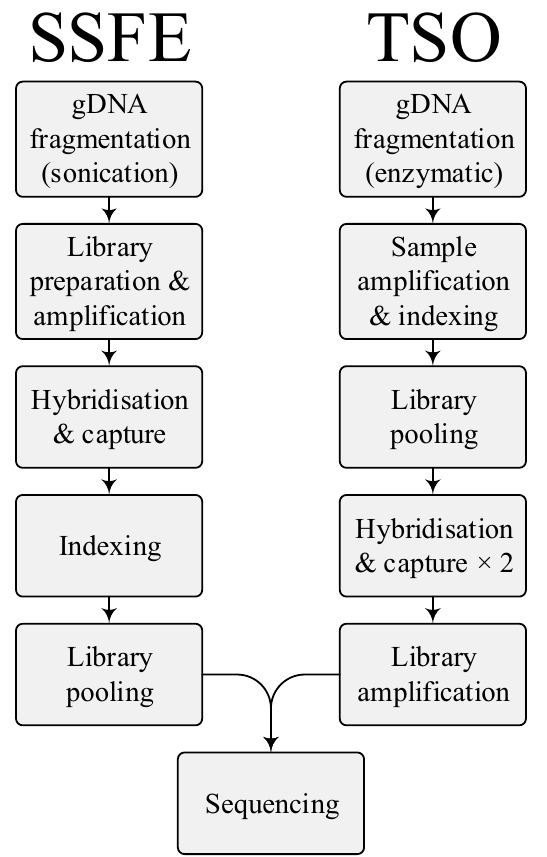
Figure 4. Overview of laboratory processes for the two capture kits. For SSFE physical fragmentation is followed by DNA fragment repair and ligation of adapter sequences; hybridisation of patient DNA with the baits and pulldown is then performed, followed by library indexing and pooling 19 . For TSO, combined fragmentation and adapter ligation is performed enzymatically, followed by sample amplification, indexing and pooling. Two iterations of bait hybridisation and pulldown are then performed, with a final pooled library amplification 18